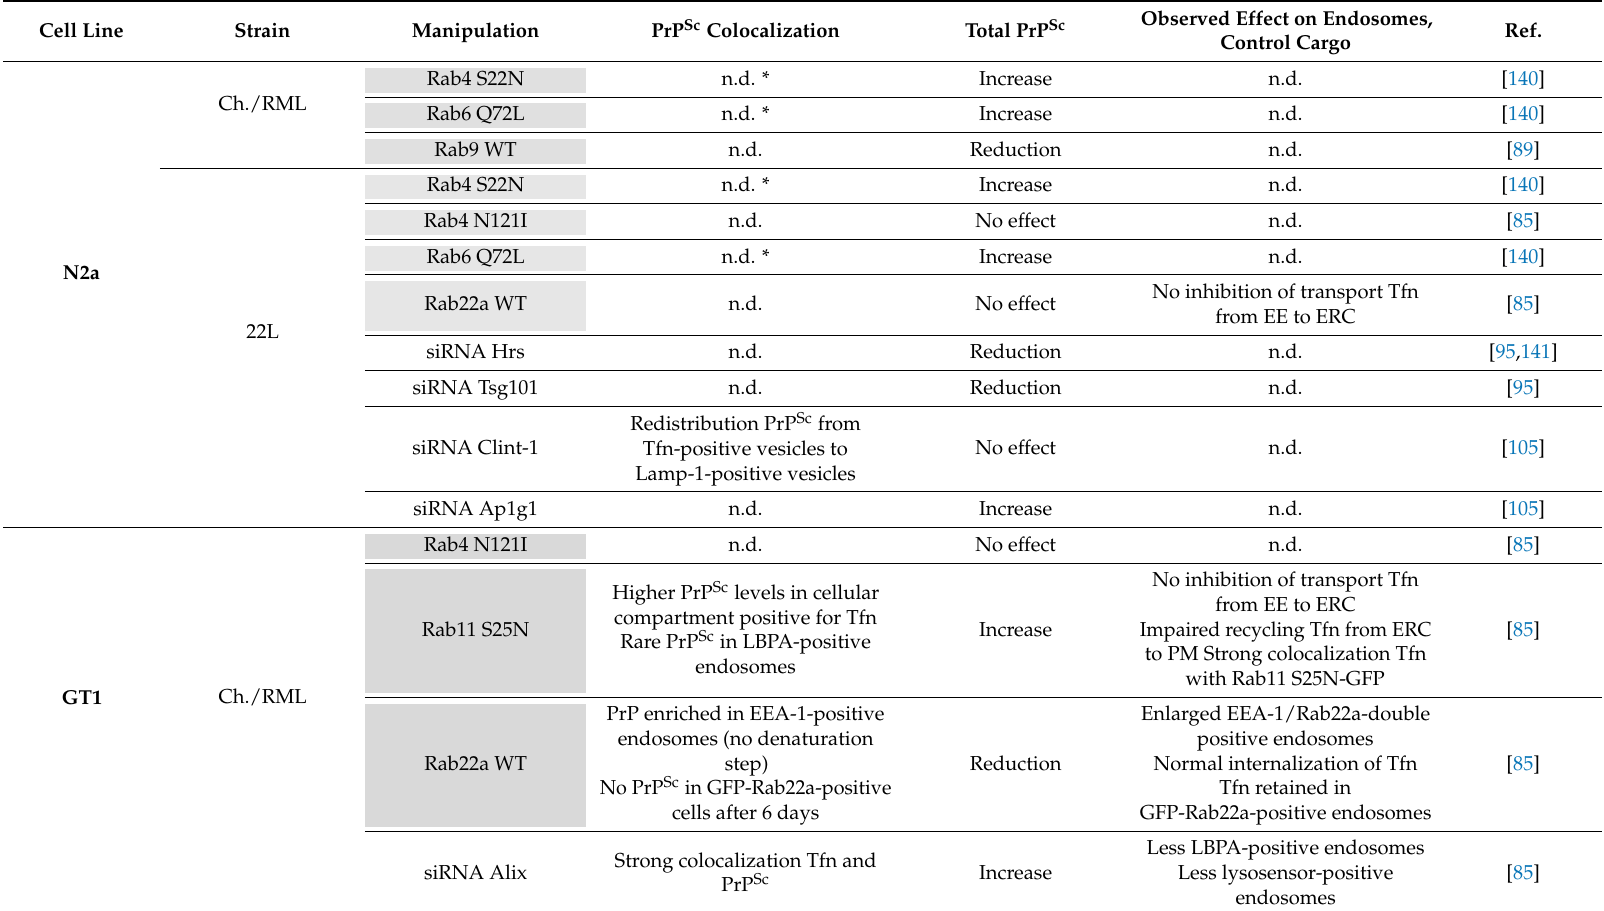
Table 3. Genetic manipulation of endoctyic trafficking and its effect on PrP Sc